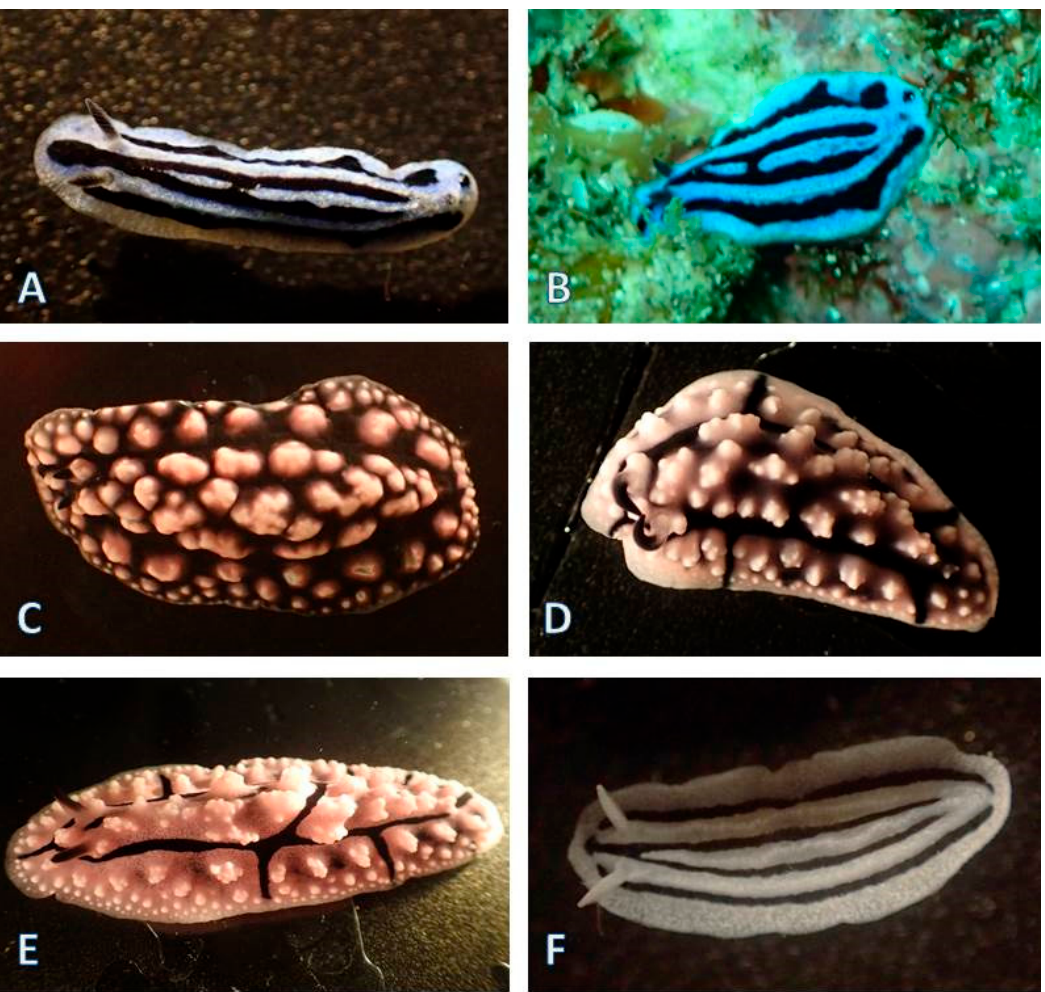
Figure 18. Nudibranchia Doridina: ( A , B ) Phyllidiopsis annae, Phsan18Ba-1 and in situ ; ( C , D ) Phyllidiopsis cf. burni, Phssp18Ba-1 ; ( E ) Phyllidiopsis krempfi, Phskre18Ba-1, Phspi18Ba-1; ( F ) Phyllidiopsis xishaensis, Phsxi18Ba-1 .